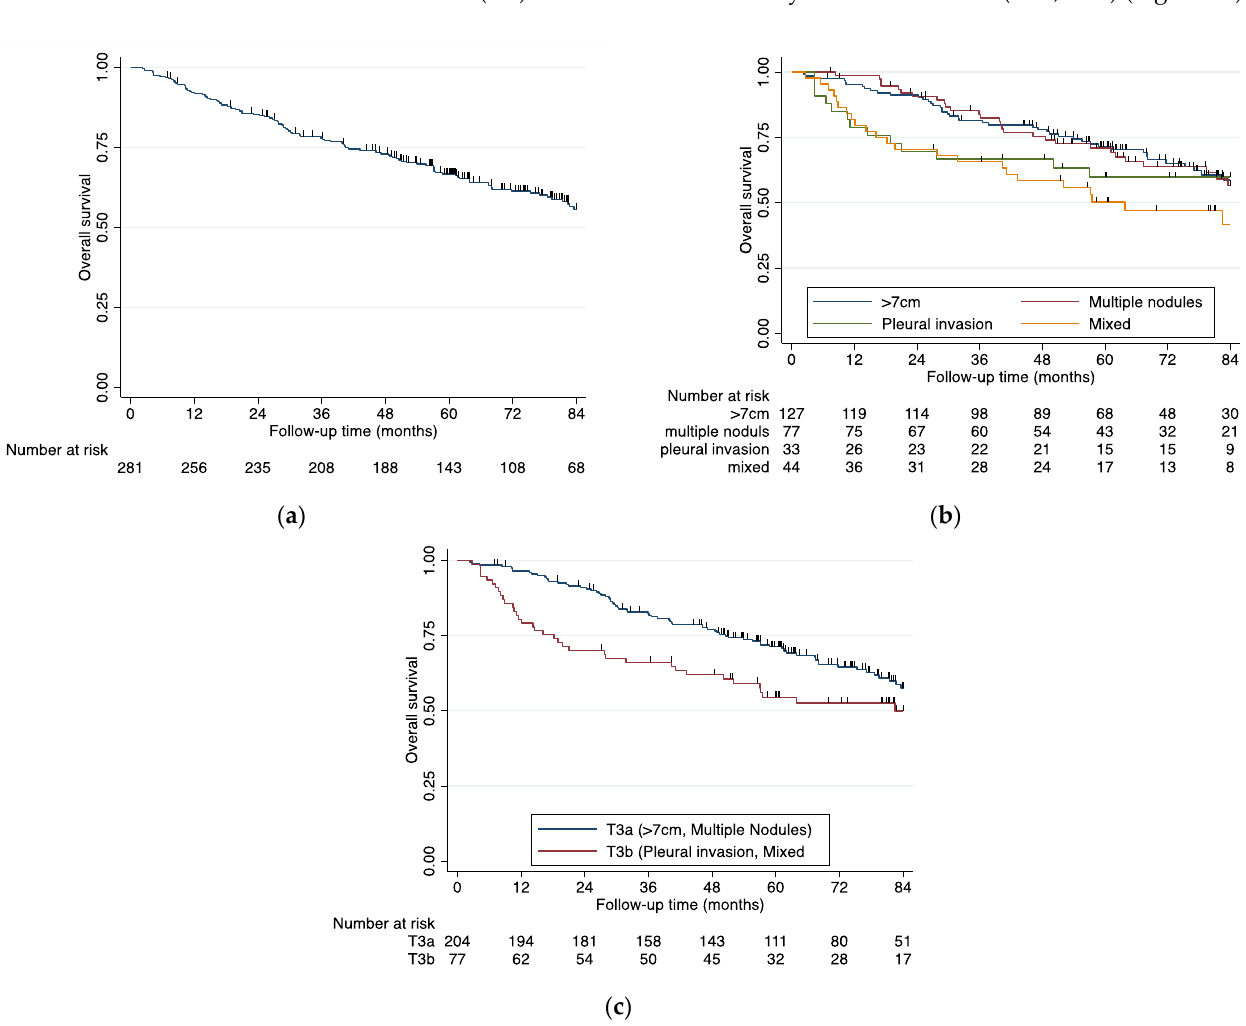
Figure 1. ( a ) Kaplan-Meier survival curve of the whole study population with pT3N0 lung cancer ( b ) Kaplan–Meier survival curves of the four major pT3N0 subtypes: tumor larger than 7 cm, second or multiple nodules in the same lobe, parietal pleural invasion, and the mixed subtype, logrank test p = 0.0085 ( c ) Kaplan–Meier survival curves of the pT3N0 lung cancer stratified for t3-descriptors grouped in T3a and T3b, logrank test p = 0.0026.